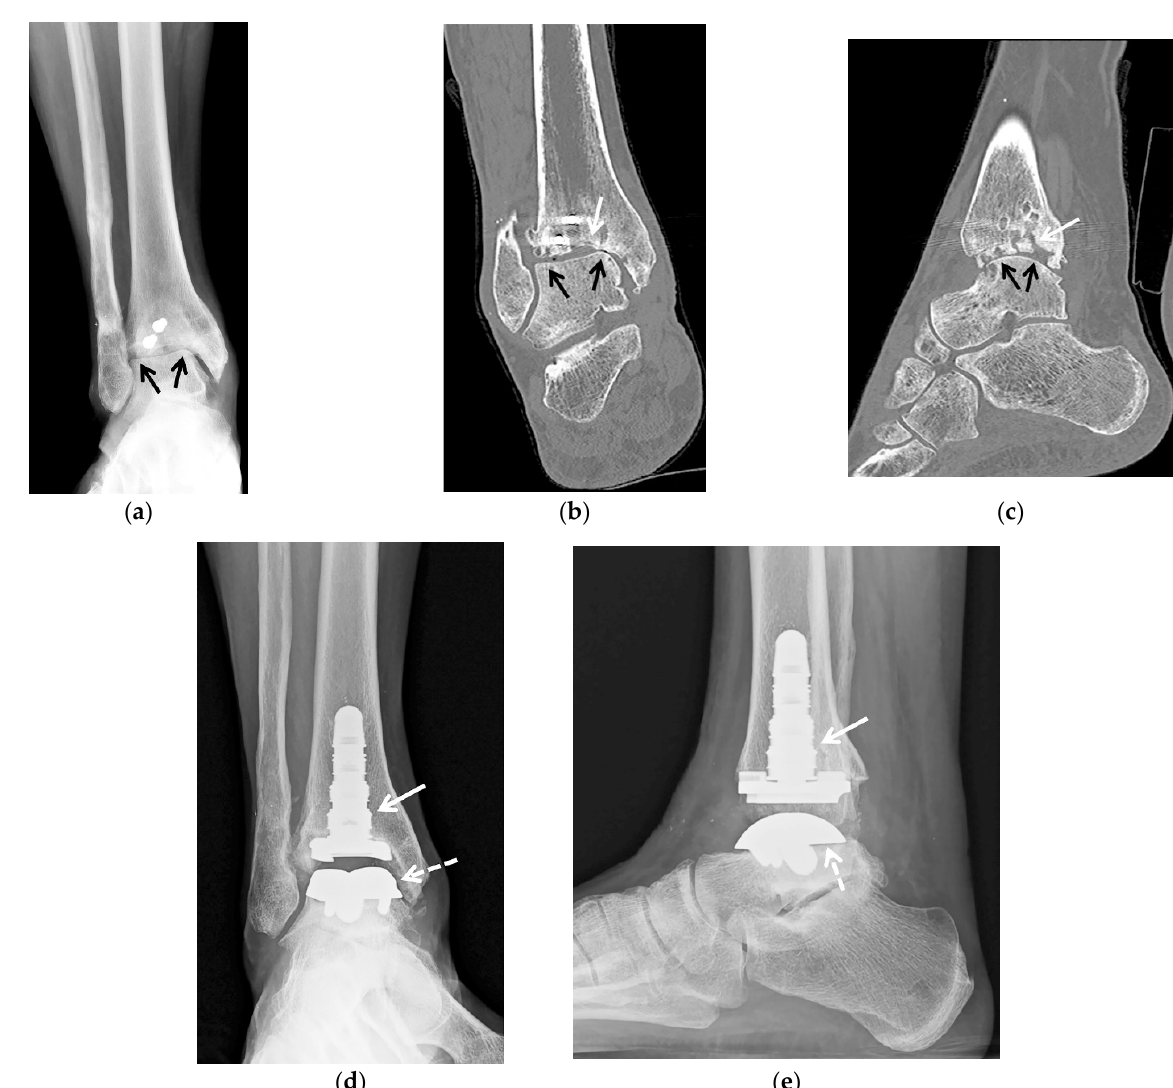
(white arrow) and talar (dashed white arrow) prosthesis components. ( f ) The intraoperative image shows tibial (white arrow) and talar components (dashed white arrow) in place.